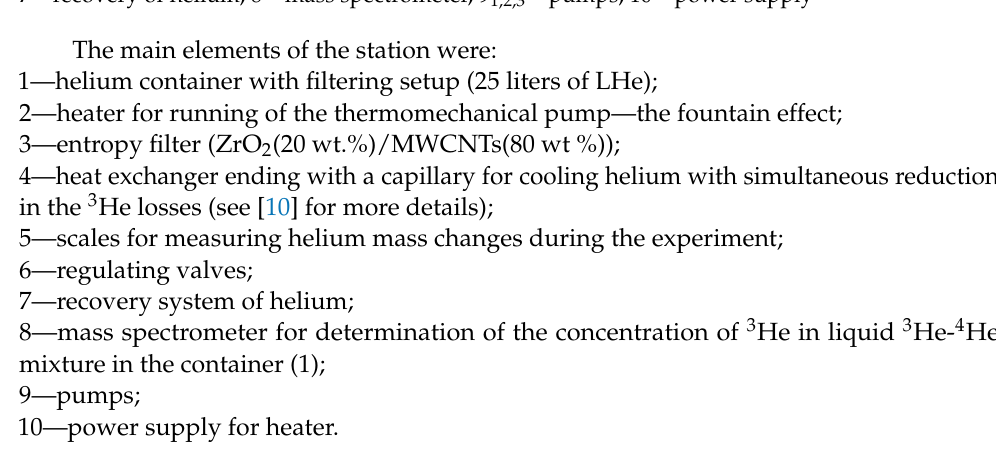
Figure 4. Test stand for determining the effectiveness of examined process: 1—helium container 25 LHe, 2—heater, 3—entropy filter, 4—capillary with heat exchanger, 5—scales, 6 1,2,3 —valves, 7—recovery of helium, 8—mass spectrometer, 9 1,2,3 —pumps, 10—power